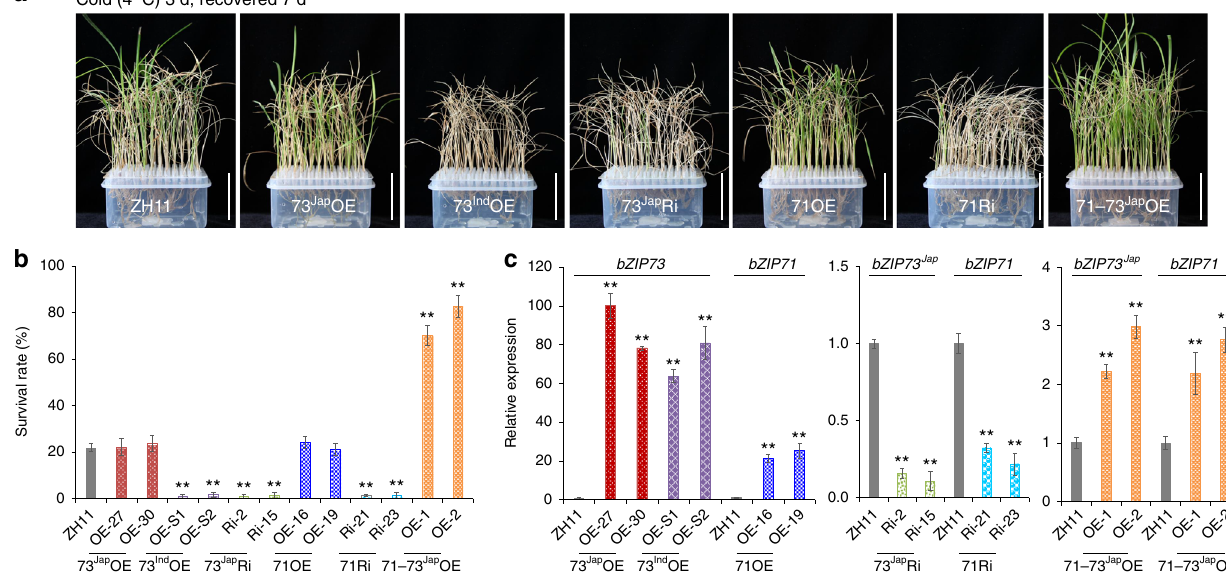
Fig. 1 Assessment of cold stress tolerance of bZIP73 and bZIP71 transgenic rice. a Overexpression lines bZIP73 Jap (73 Jap OE), bZIP73 Ind (73 Ind OE), and bZIP71 (71OE), co-expression lines bZIP71 - bZIP73 Jap (71 – 73 Jap OE), and RNAi lines bZIP73 Jap (73 Jap Ri) and bZIP71 (71Ri) were cold treated at 4 °C for 3 days and are shown after recovery at 28 °C for 7 days. ZH11, wild-type Zhonghua 11. b Survival rates of ZH11 and transgenic lines recovered after cold treatment. Scale bars, 5 cm. c Relative expression levels of bZIP73 and bZIP71 in ZH11 and transgenic lines measured by real-time PCR under normal condition. Target genes for measurement are indicated on top of the plot, and expression levels in ZH11 (wild-type plants) was used as reference (1×) to show expression fold change ( y -axes) in transgenic lines as indicated on x -axes. Due to the different scale of relative expression levels, data were separated into three subplots. All data were collected using two independent homozygous lines indicated on x -axes with three biological replicates ( n = 288 each). Error bar, standard deviation; ** p < 0.01, two-tailed t -test in comparison to